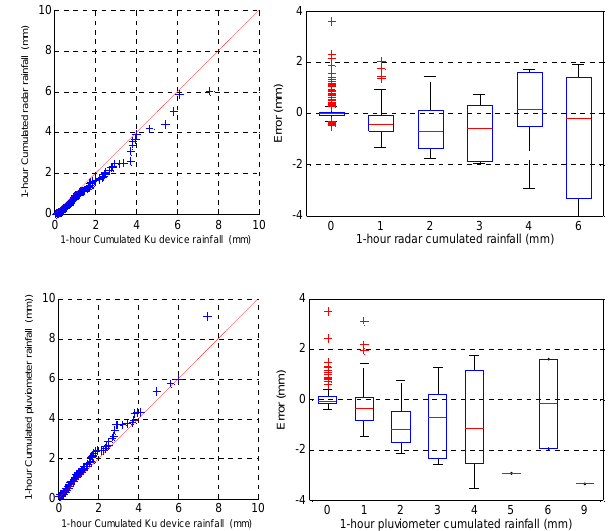
Fig. 11. Q–Q plots using radar and Ku device data (top left), and rain gauge and Ku device data (bottom left). Box plots made using radar and Ku device data (top right), and rain gauge and Ku device data (bottom right).